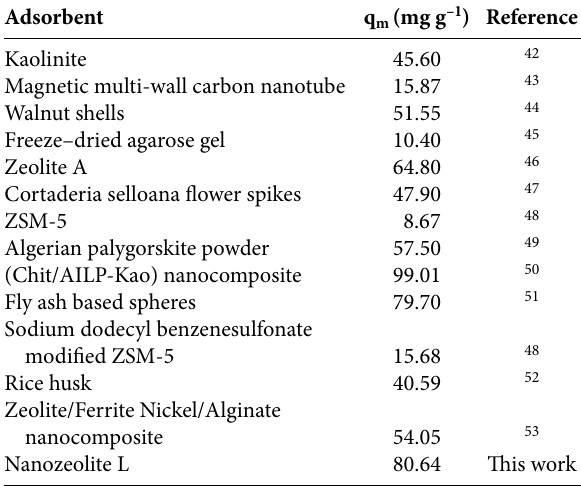
Table 3. Comparison of maximum adsorption capacities of various adsorbents for MB Adsorbent